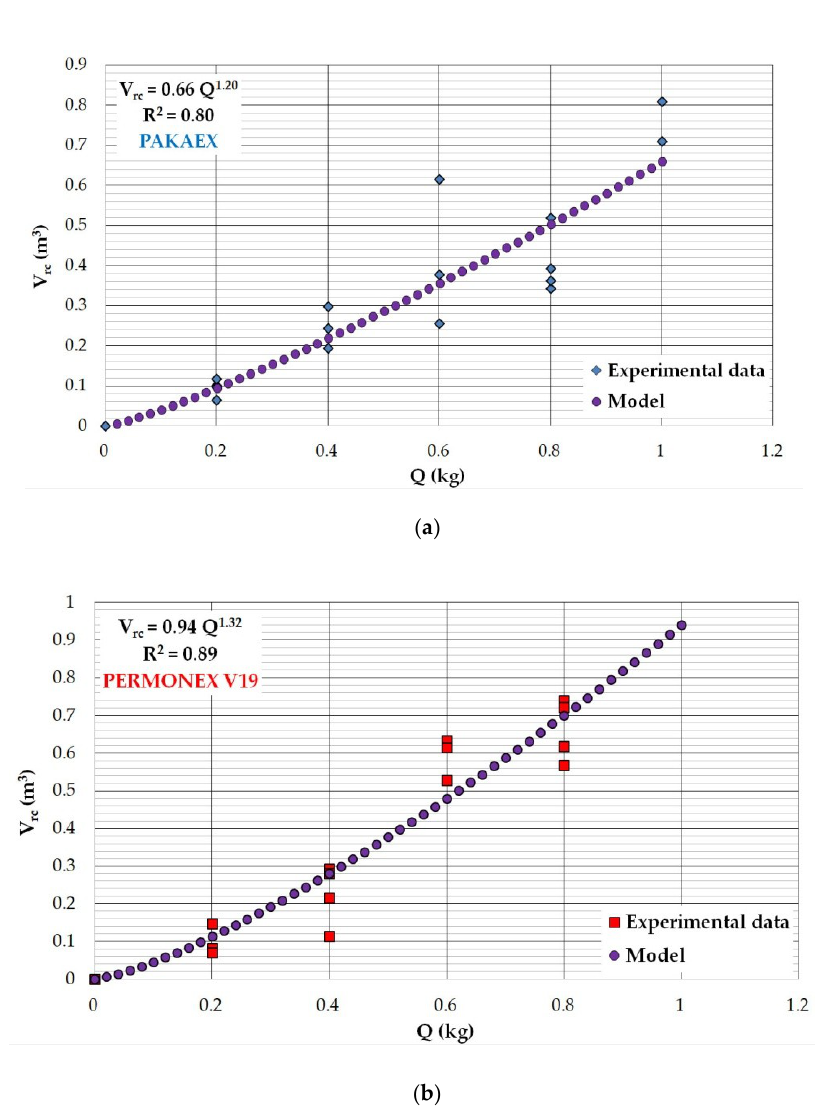
Figure 13. ( a ) The mathematical model plots of the lowest AIC c values for the resulting expansion volume V rc (m 3 ) for Pakaex. ( b ) The mathematical model plots of the lowest AIC c values for the resulting expansion volume V rc (m 3 ) for Permonex V19.